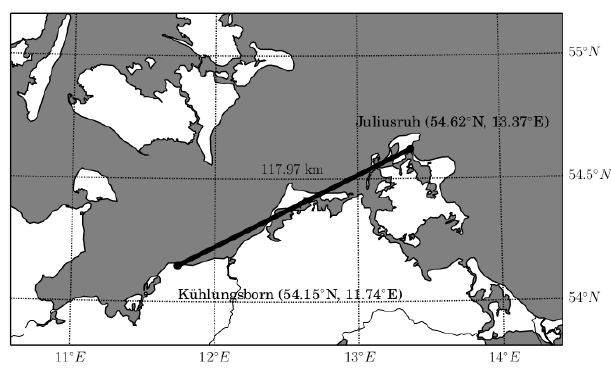
Figure 3. Geometry for the bistatic meteor radar experiment. The transmitter was located in Juliusruh, and the receiver was located at Kühlungsborn, a 118km great-circle distance from the